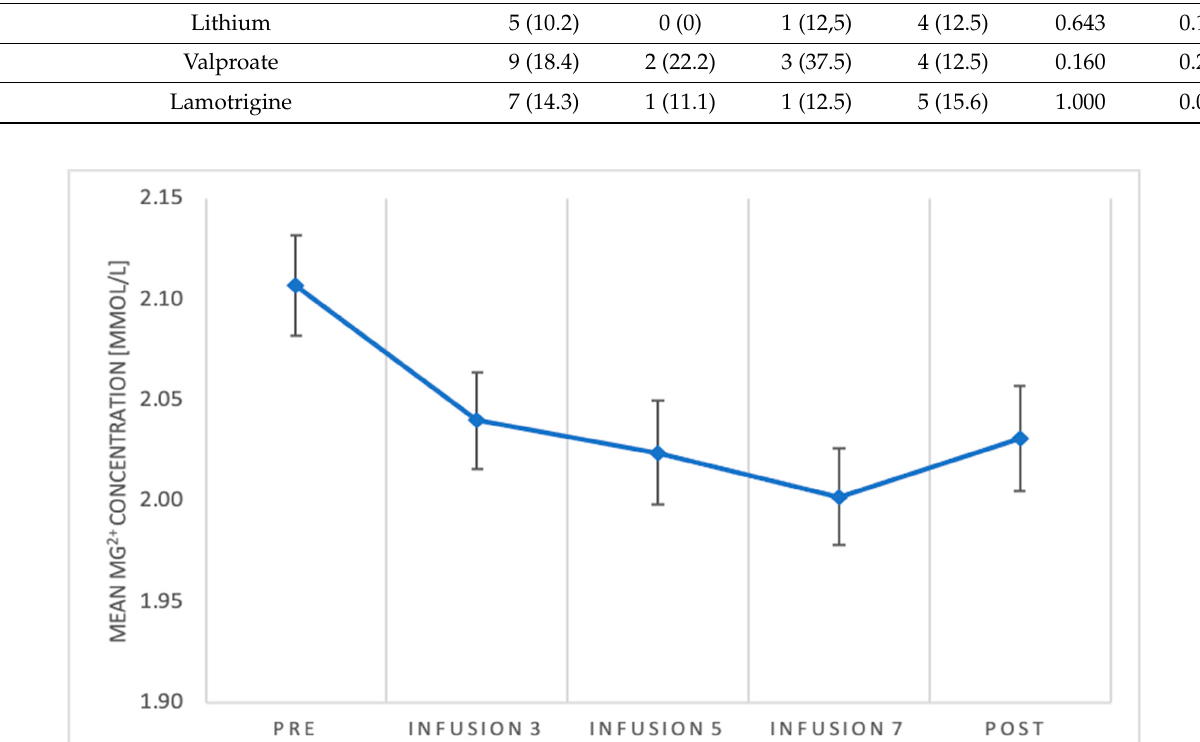
Figure 2. Mean Mg 2+ concentration and standard errors of the mean for the concentration of Mg 2+ ions in individual meas- urements .